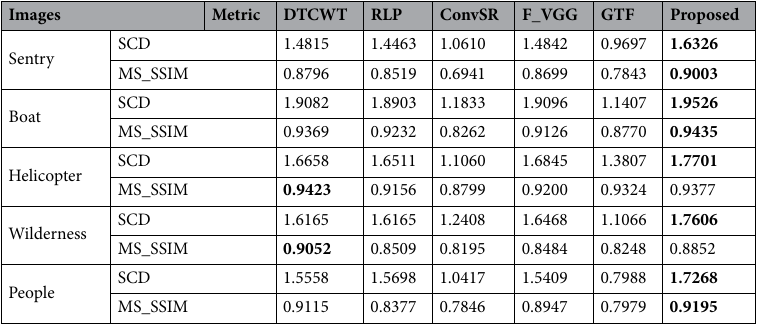
Table 5. Quantitative comparison of different fusion methods. Bold values represent the best fusion effect. The larger the value of the evaluation metric, the better the fusion effect.